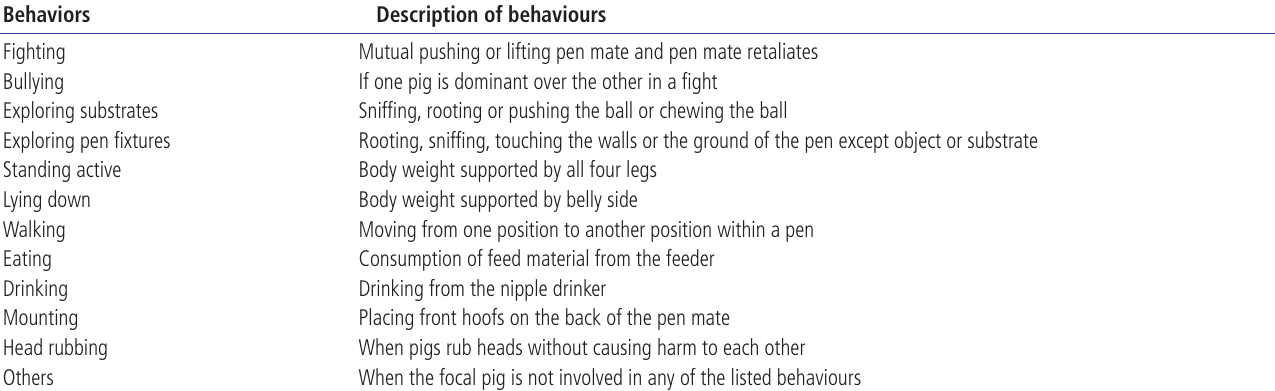
Table 1. Ethogram of behavioral activities in barren and enriched environments Behaviors Description of